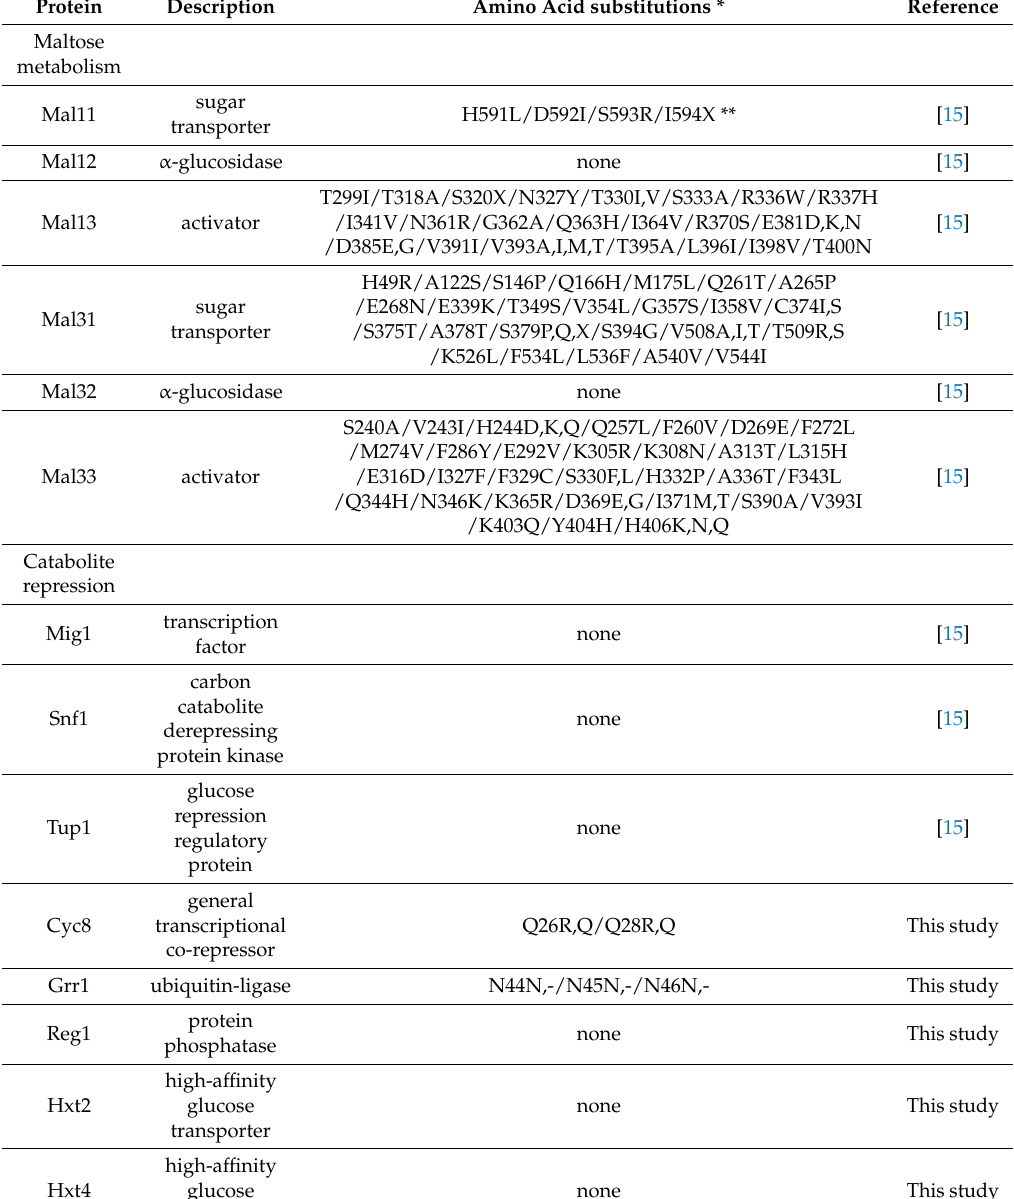
Table 2. Amino acid substitutions/deletions in maltose metabolism and catabolite repression-related proteins of